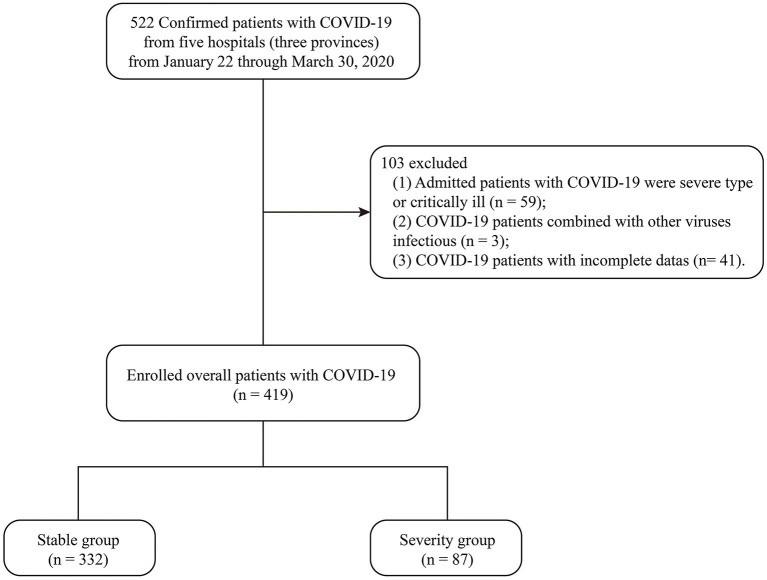
Flowchart of COVID-19 patient enrollment including the stable group and the severe group.